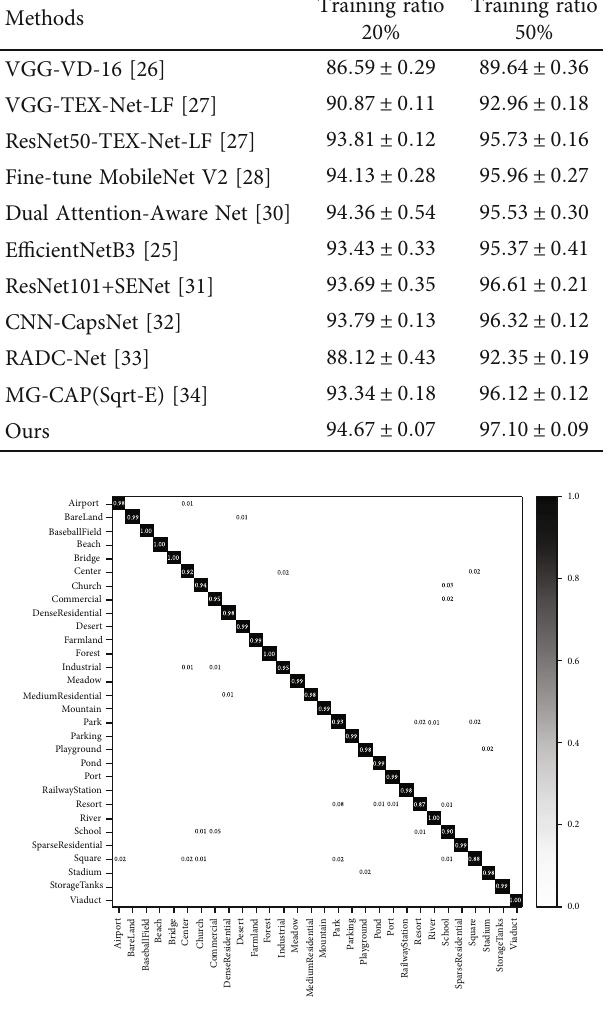
Figure 7: Confusion matrix under the 50% training ratio on AID data set.